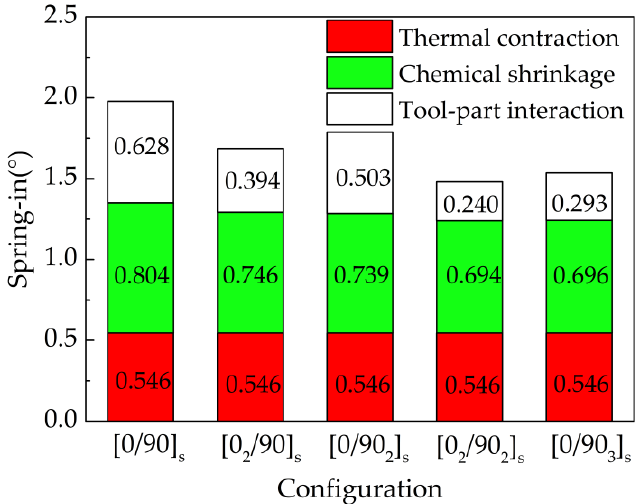
Figure 9. Spring-in caused by three spring-in sources for L-shaped parts.